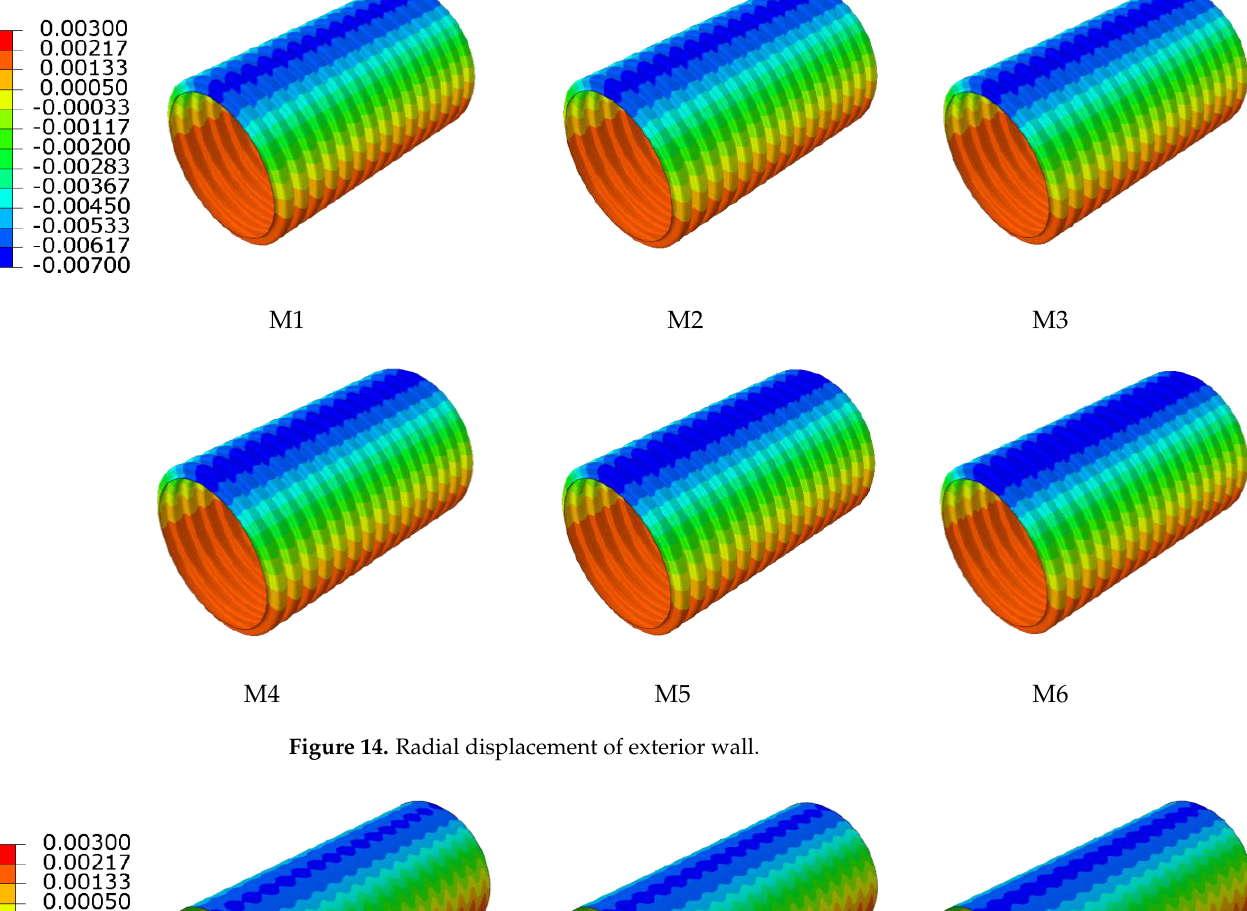
Figure 14. Radial displacement of exterior wall.